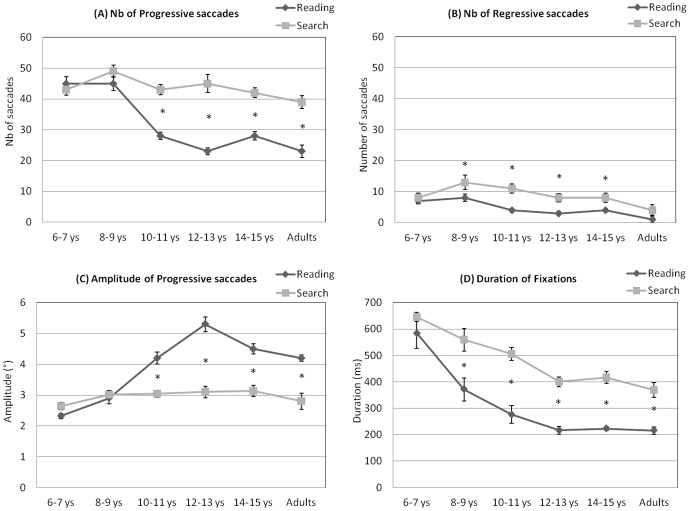
Comparisons of reading and visual search task for the six groups of participants tested on: number of progressive saccades (A), number of regressive saccades (B), amplitude of progressive saccades (C) and duration of fixations (D).Vertical lines indicate the standard error. Asterisks indicate that value is significantly different between reading and visual search task.